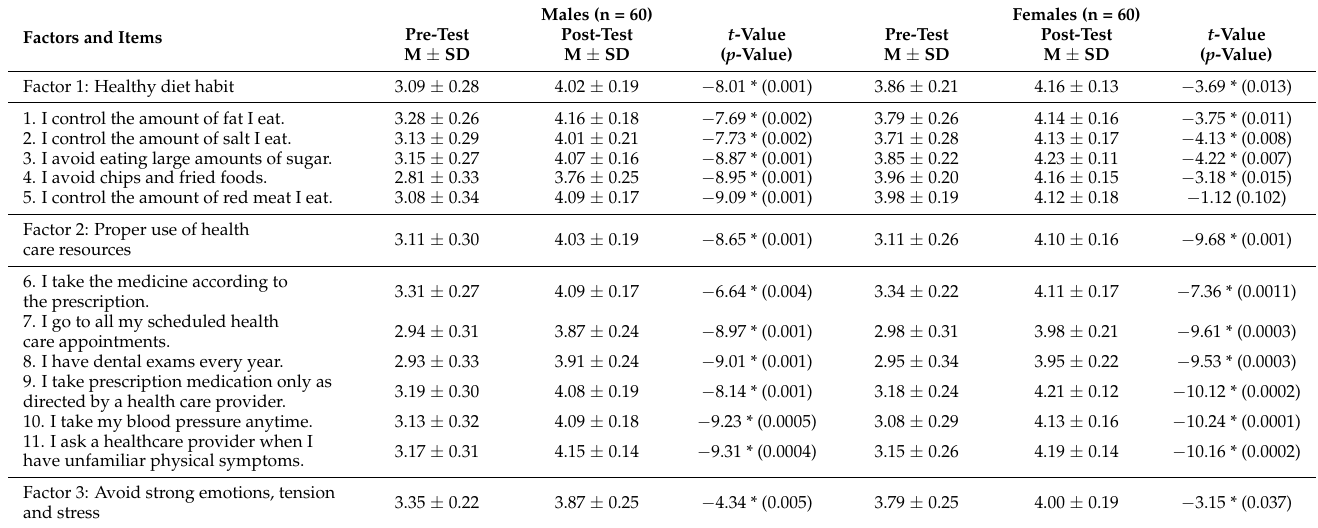
Table 5. Factors and items of Health Behavior